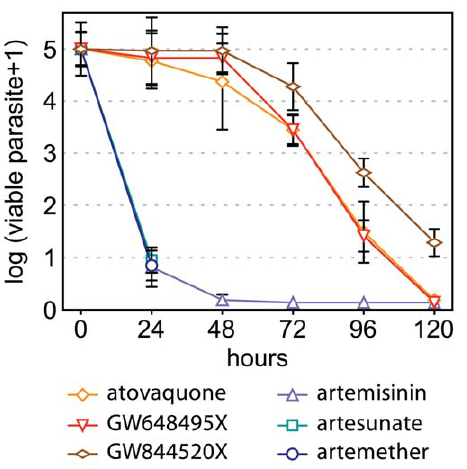
Figure 7. Single time-point viability measurement. P. falciparum viability after 72 hours of treatment with the indicated drugs, reported as the log of viable parasite + 1, as compared to the untreated controls. The red line represents the threshold of 99.9% parasite reduction. The data are representative of at least 3 independent experiments.